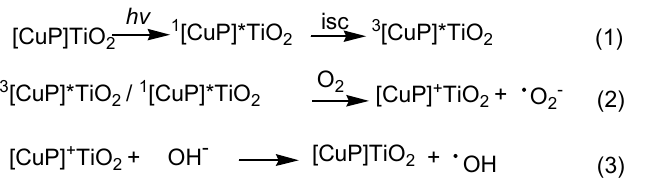
Figure 6. Photodegradation of MO by TiO